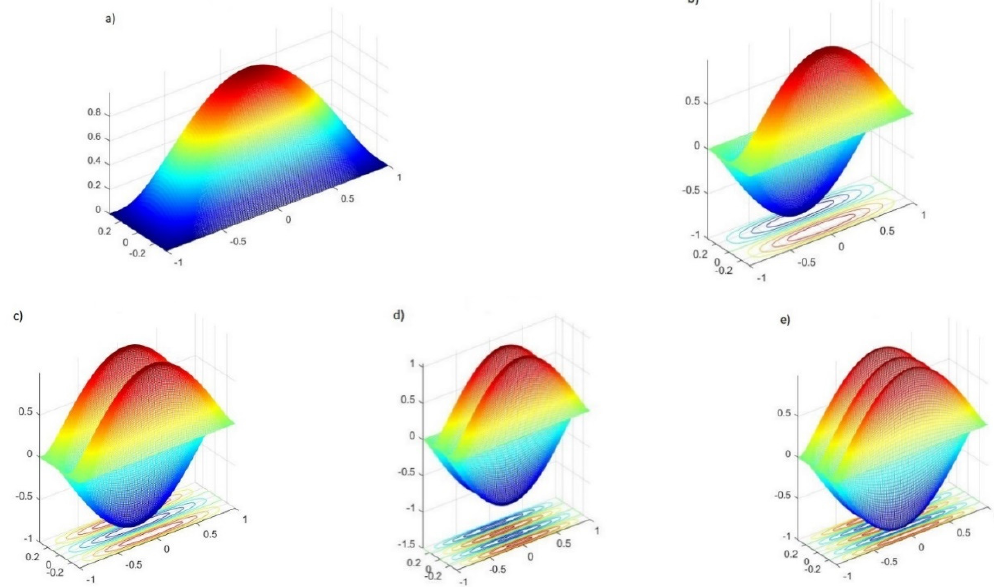
Figure 13. Vibrational modes for the UD distribution without the agglomeration effect: ( a ) 1st mode, ( b ) 2nd mode, ( c ) 3rd mode, ( d ) 4th mode, ( e ) 5th